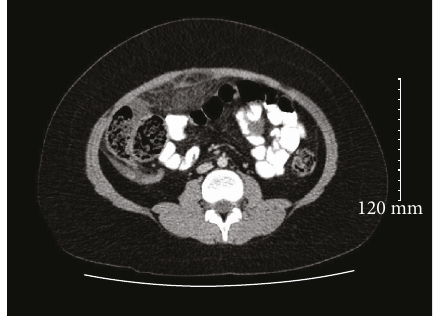
Figure 1: Axial CT demonstrating a small amount of free fl uid around the omentum.